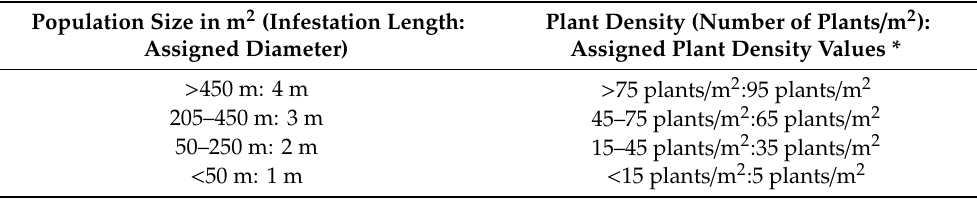
Table 1. Classification of Sagittaria platyphylla population size and plant density.